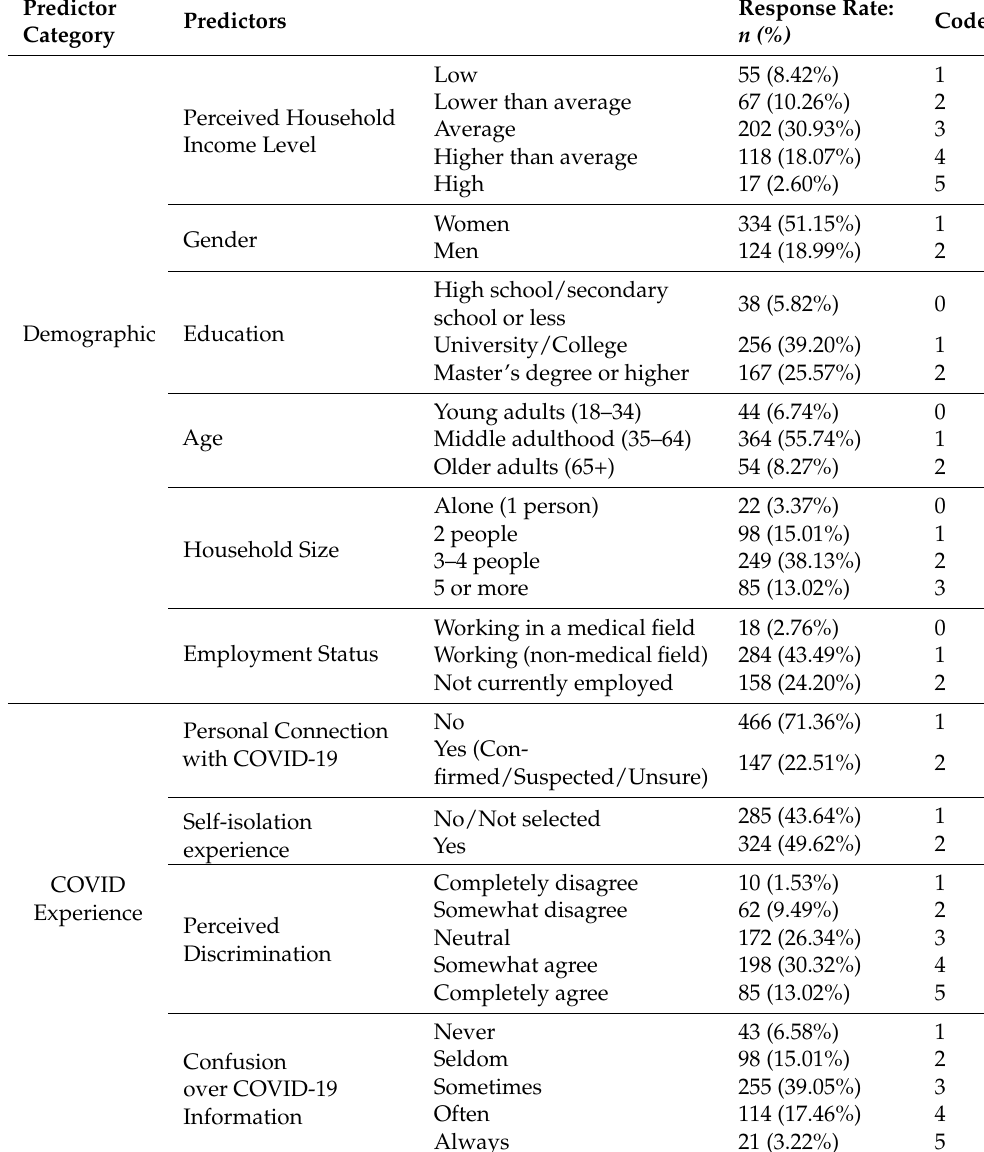
Table 1. Predictors included in the model ( n =